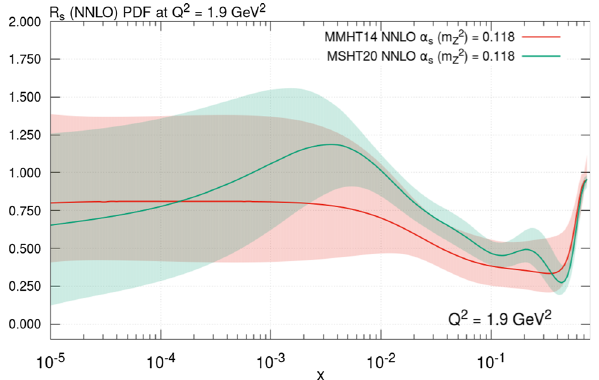
Fig. 29 R s PDF, for MSHT20 and MMHT14 at NNLO and Q 2 = 1 . 9 GeV 2